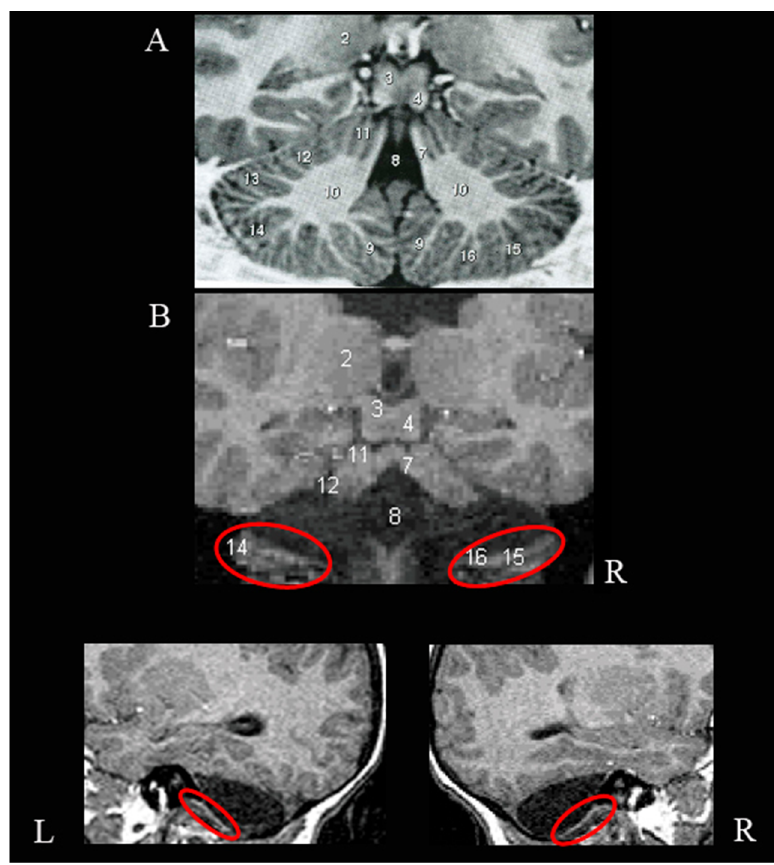
Figure 1. Agenesis of the cerebellum. Neuroradiological examination of the cerebellum when the girl was 5.7 years old. (Panel A ) is a slice of the cerebellum atlas, (Panel B ) is the same slice in the girl’s cerebellum. Cerebellar regions are named according to Schmahmann et al. (1999): 2, pulvinar thalami; 3, superior colliculus; 4, inferior colliculus, 7, superior cerebellar peduncle; 8, fourth ventricle; 11, hemisphere lobules IV-V (anterior quadrangular lobule); 12, hemisphere lobule VI (posterior quadrangular lobule); 14, Crus II (inferior semilunar lobule); 15, hemisphere lobule VIIB (gracilis lobule); 16, hemisphere lobules VIIIA and VIIIB (biventer lobule). L = left; R =